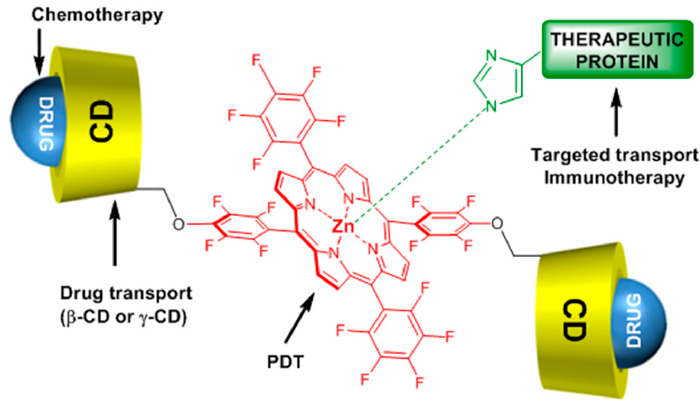
Figure 21. Schematic representation of Lego-like systems (including three parts: therapeutic protein, ZnP( β -CD) 2 or ZnP( γ -CD) 2 conjugates, and a chemotherapy drug) for targeted and combined therapy. Adapted from Kejik; Briza; Kralova; Pouckova; Kral; Martasek; Kral [141].